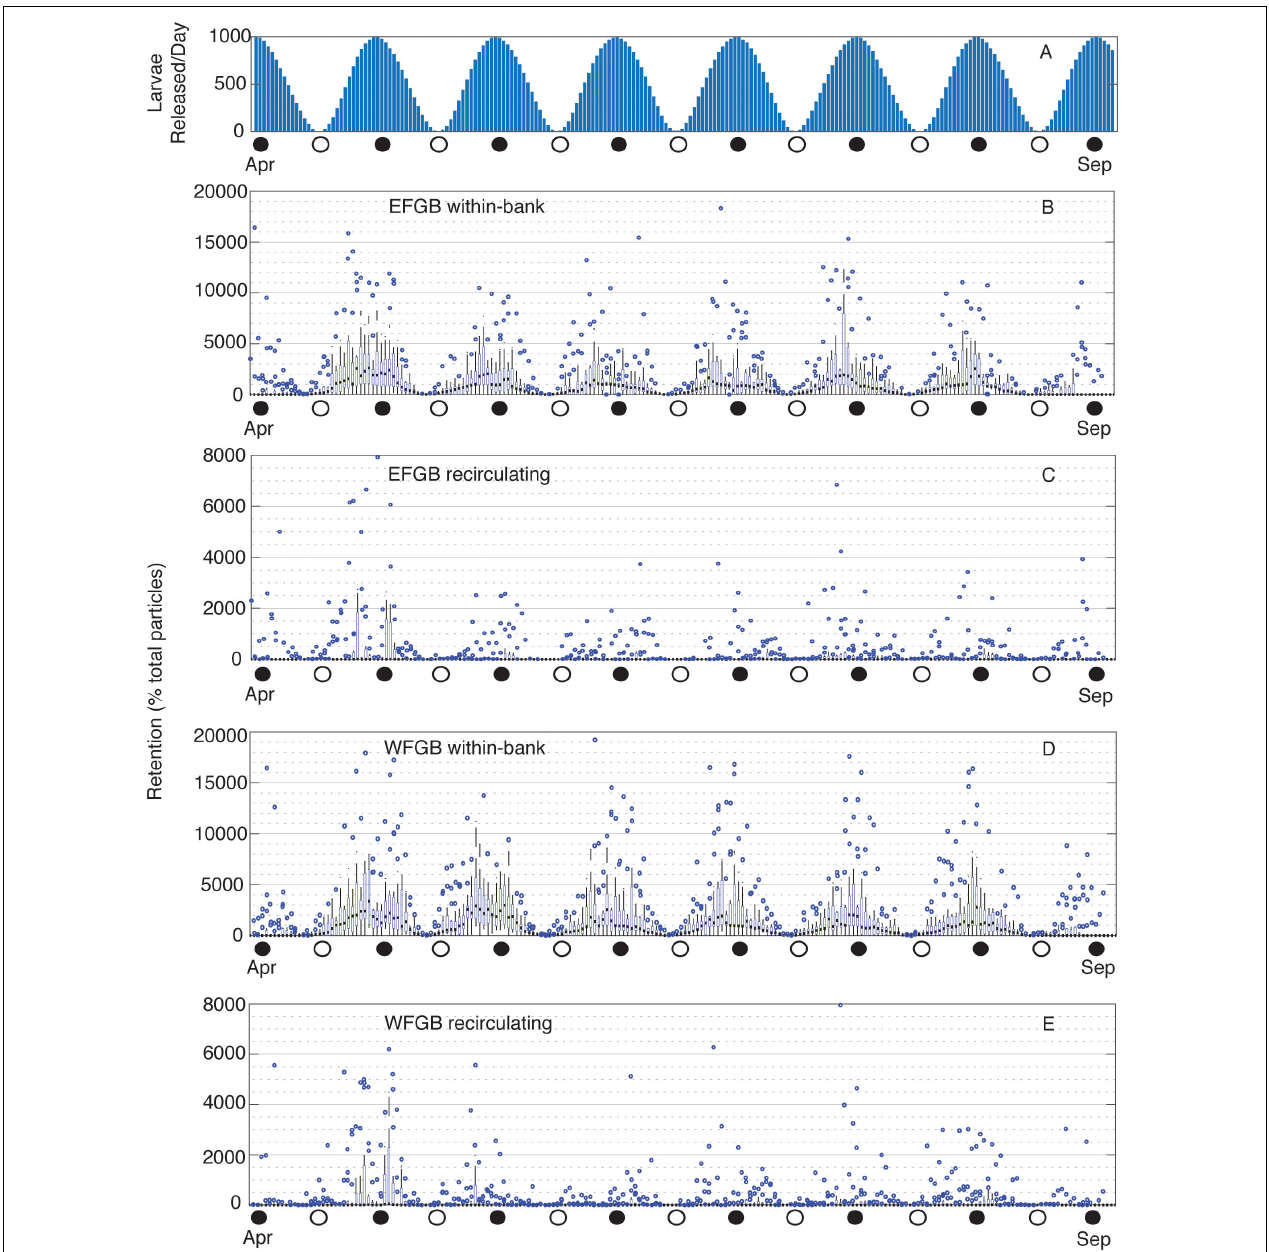
FIGURE 6 | Particles released per lunar day and daily EFGB and WFGB P. astreoides local retention. (A) Number of particles released per lunar day from April to September. (B) EFGB total within-bank retention, and (C) total recirculating retention, followed by (D) WFGB total within-bank retention, and (E) total recirculating retention. Box plots show the annual distribution of the number of particles locally retained at WFGB per lunar day across 15 years of seasonal planulation (2004–2018). Boxes represent interquartile ranges, black squares are median values, blue circles are outliers, and whiskers represent the first and fourth quartiles. Note different y-axis